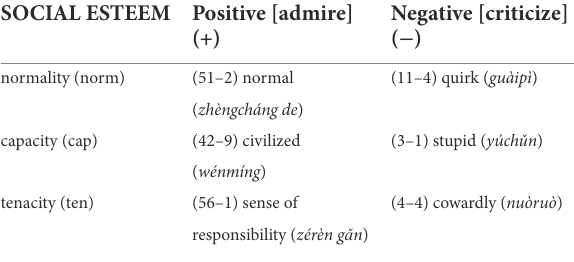
TABLE 2 Categories of judgment of esteem.